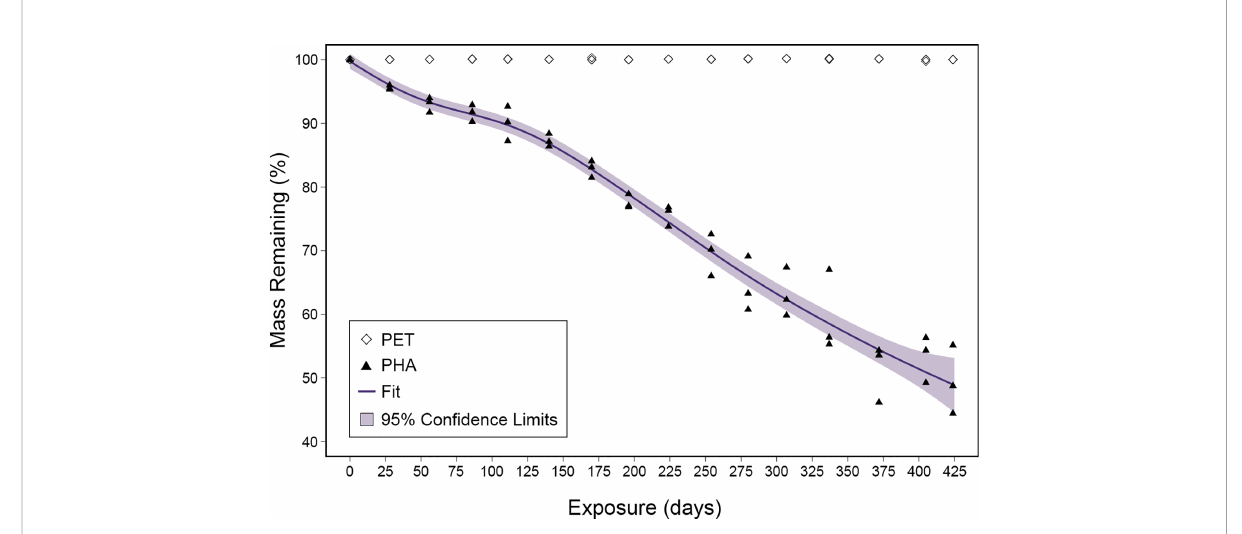
FIGURE 1 Mass loss ratios plotted for both PHA and PET over the 424-day exposure. The fi t of the generalized additive mixed model is displayed as a purple line and the 95% con fi dence limits are shown as light purple